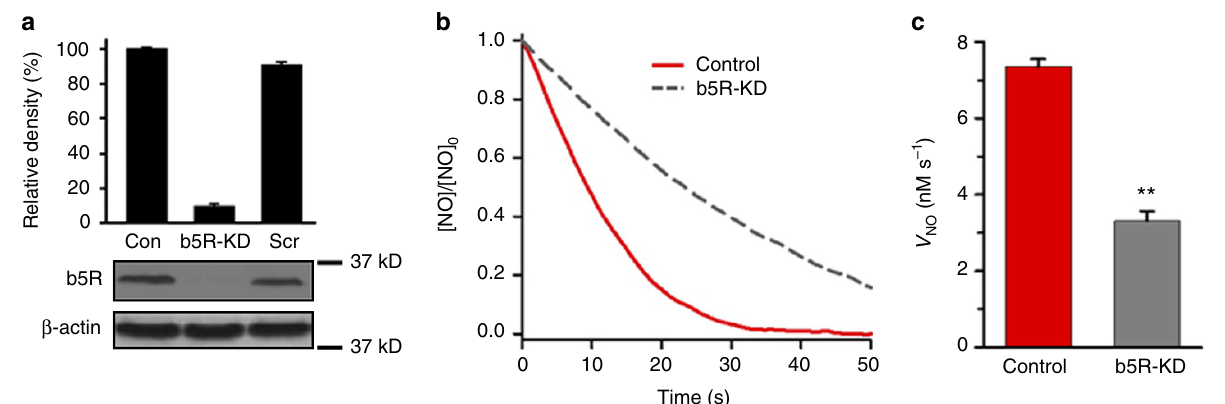
Figure 4 | Effect of b5R on the rate of NO consumption by aortic smooth muscle cells. Relative amount of b5R in rat aortic vascular SMCs was estimated by quantitative immunoblotting before and after knockdown of b5R. Positions of nearest molecular weight markers are shown. ( a ) NO consumption by 7 (cid:2) 10 6 control SMCs per ml and by 7 (cid:2) 10 6 b5R -KD SMCs per ml. ( b ) NO was injected into the solution to achieve an initial concentration of 0.5 m M. Means and standard errors of the rate of NO decay by 7 (cid:2) 10 6 SMCs per ml and 7 (cid:2) 10 6 b5R -KD SMCs per ml ( c ). Error bars: mean ± s.e.m., n ¼ 6 per group, ** P o 0.01 control SMCs versus b5R -KD SMCs; P values determined using a two-tailed